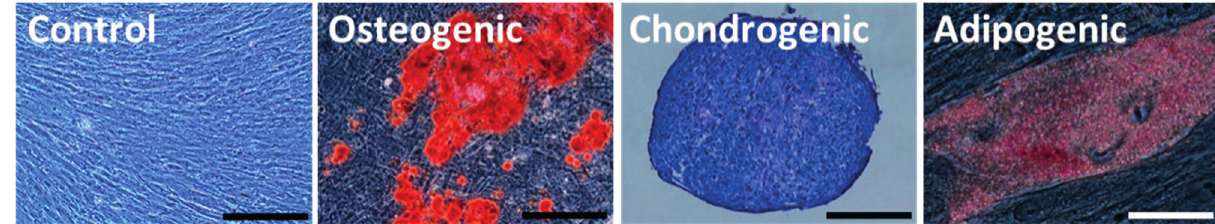
Figure 4. Trilineage differentiation of MSC-like cells. MSC-like cells derived from HGF-iPSCs 1-1 (MSLCs 1-1) at passage 45 were tested for their capacity of trilineage differentiation. Passage 8 MSLCs were osteogenic-, adipogenic-, and chondrogenic-differentiated for 21 days. MSLCs in control conditions were assessed for 21 days. Calcium deposition in osteogenic-differentiated MSLCs 1-1 was detected by Alizarin Red, in contrast to control conditions. Small lipid droplets in the cytoplasm of adipogenic-differentiated MSLCs 1-1 were observed by Oil Red O staining. Proteoglycan-rich extracellular matrices of chondrogenic-differentiated MSLCs 1-1 were stained red-purple by toluidine blue. Black Scale bar = 400 μ m, white Scale bar = 200 μ